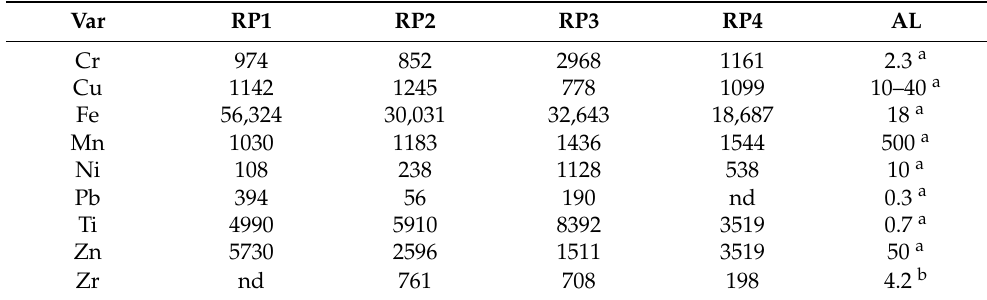
Table 6. Edible plants PTEs (in